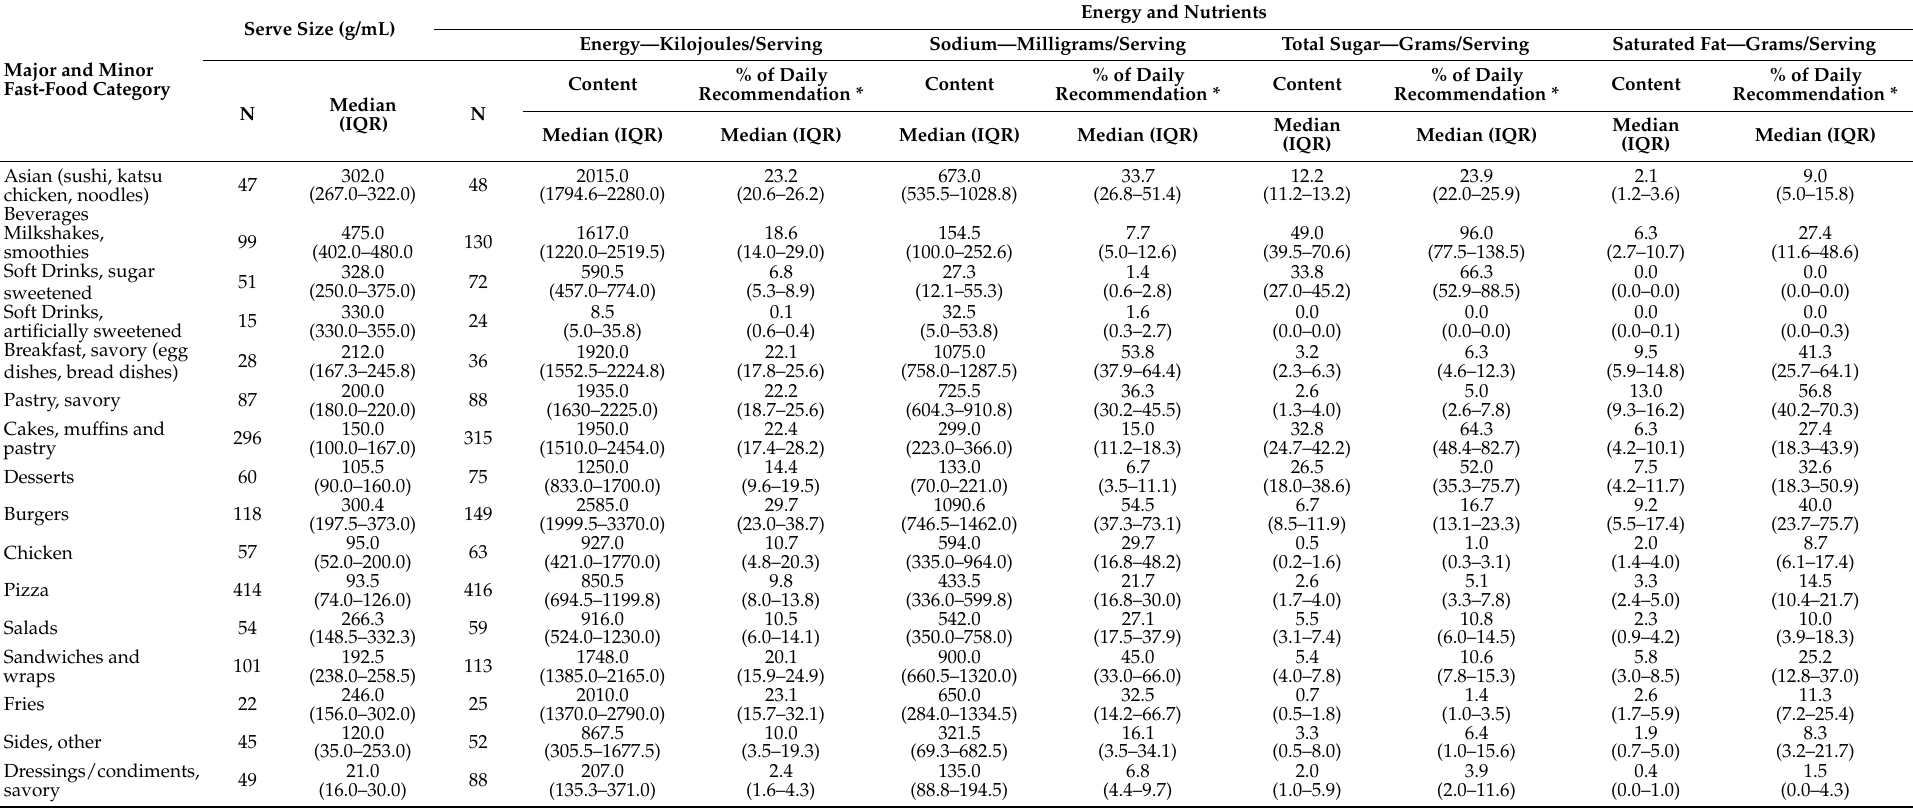
Table 1. NZ fast food supply 2020, by food category: Median (interquartile ranges) for: total energy, sodium, sugar and saturated fat content by serving size and percent energy, sodium, sugar and saturated fat contributions to recommended daily